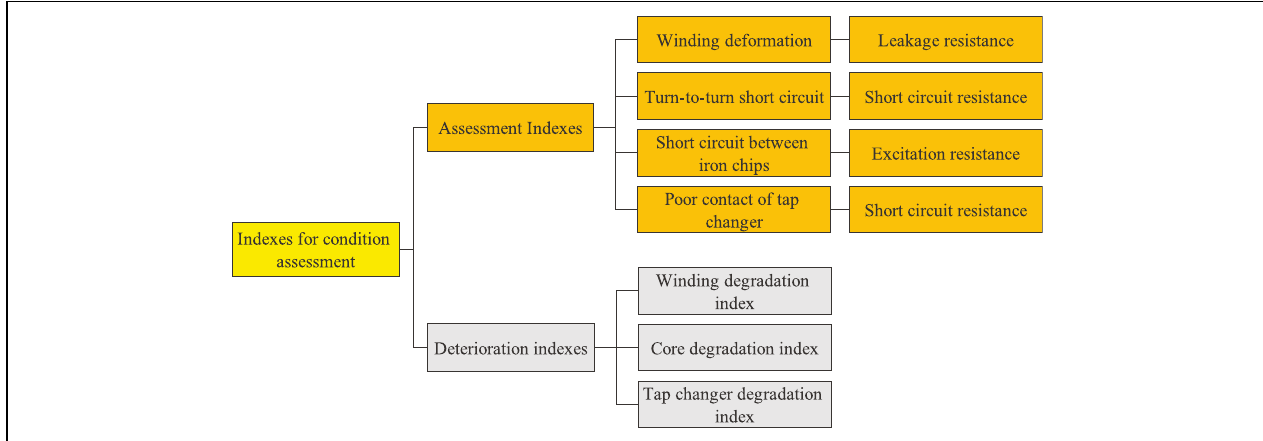
FIGURE 1 | Transformer condition assessment index system.